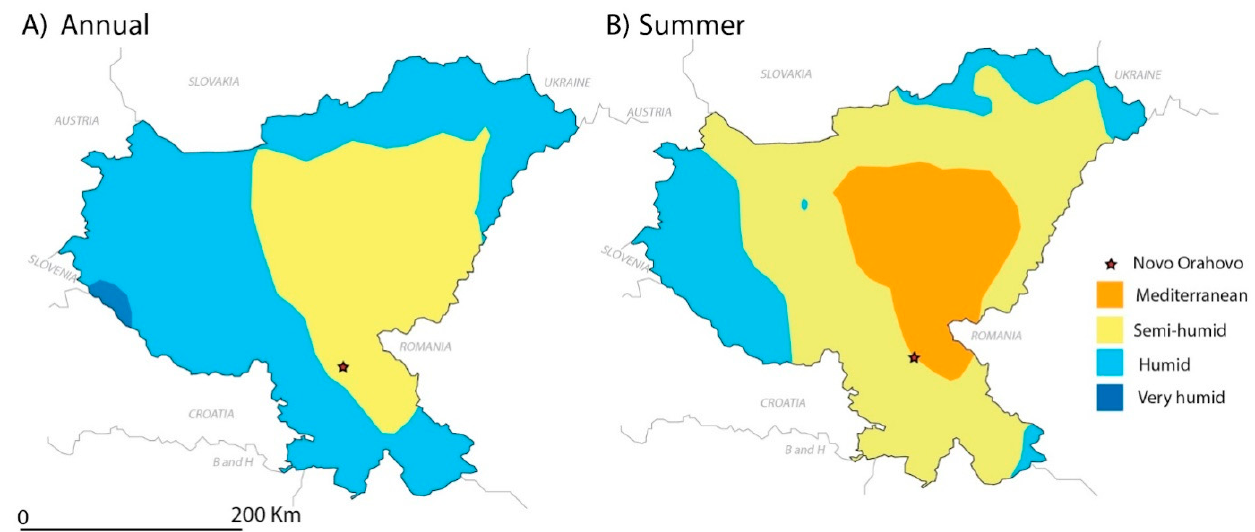
Figure 7. The spatial distribution of the De Martonne Aridity Index for Hungary and Vojvodina jointly during the period 1949–2017: ( A ) annual, ( B ) summer (Gavrilov et al., 2021, modified) [69]. The star symbol indicates the position of the Novo Orahovo loess site.